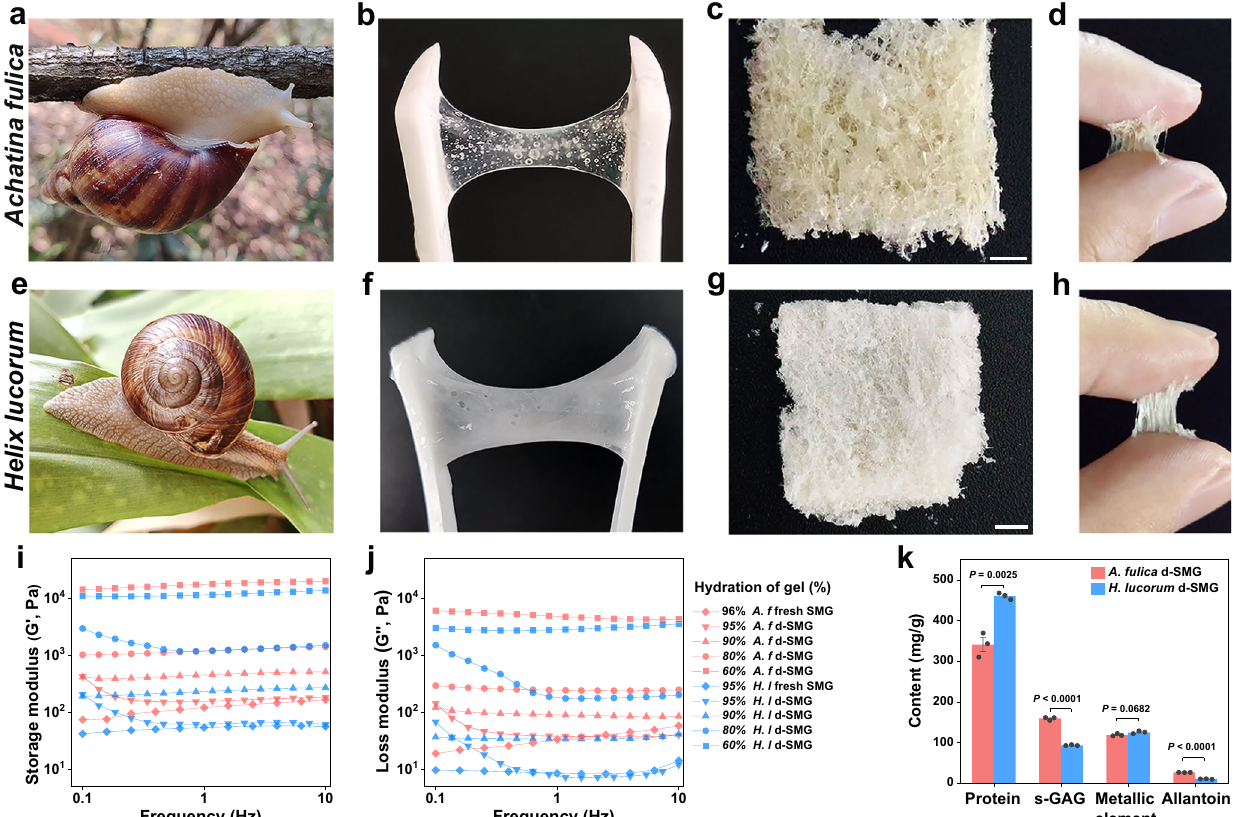
Fig. 1 | Characterizations ofd-SMGs. a – d Photograph of A. fulica ( a ),fresh mucus from A.fulica ( b ), d-SMG from A.fulica ( c ),and adhesion of A.fulica d-SMG on skin ( d ). e – h Photographof H.lucorum ( e ),freshmucusfrom H.lucorum ( f ),d-SMGfrom H. lucorum ( g ),and adhesion of H. lucorum d-SMG on skin ( h ). i – j Storagemodulus ( i )andlossmodulus( j )ofSMGandd-SMGwithdifferenthydrationratio(redfor A.